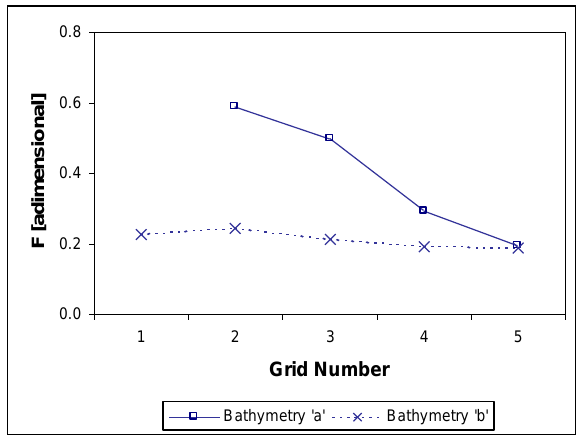
Figure 6. Comparison of F values, with LiDAR and the cross- section topographic data (bathymetries „a‟-„b‟)